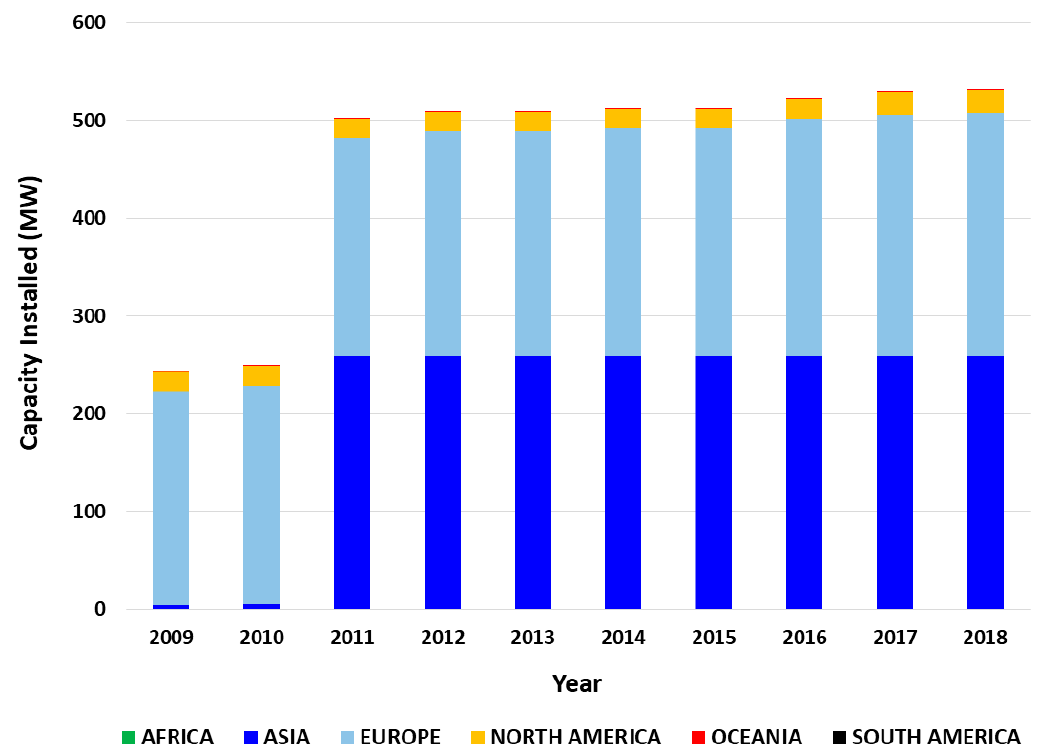
Figure 9. Marine energy: capacity installed by continents, according to the International Renewable Energy Agency (IRENA) (2019) [152].